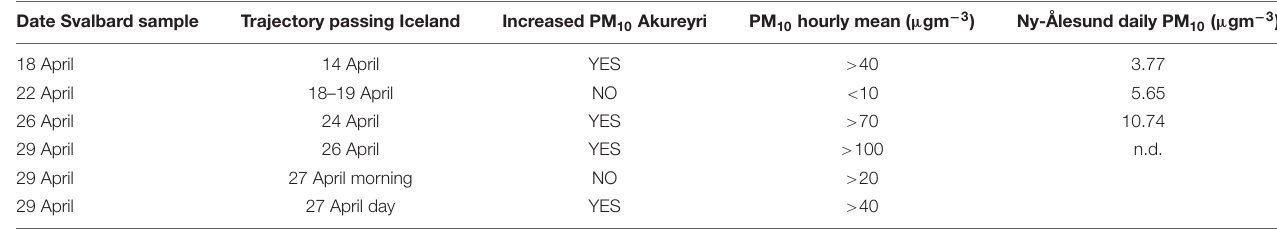
TABLE 2 | Dates of dust days in Iceland and corresponding PM 10 concentrations at Akureyri and dust load in Ny-Ålesund. Date Svalbard sample